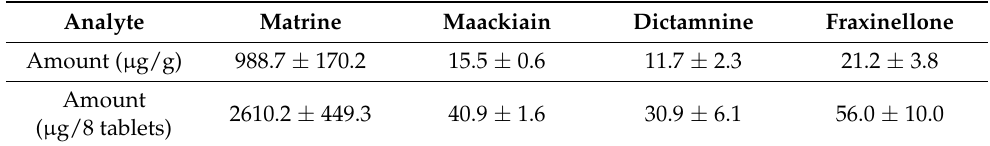
Table 2. Amounts of ATB key active compounds in the ATB supplement tablets.